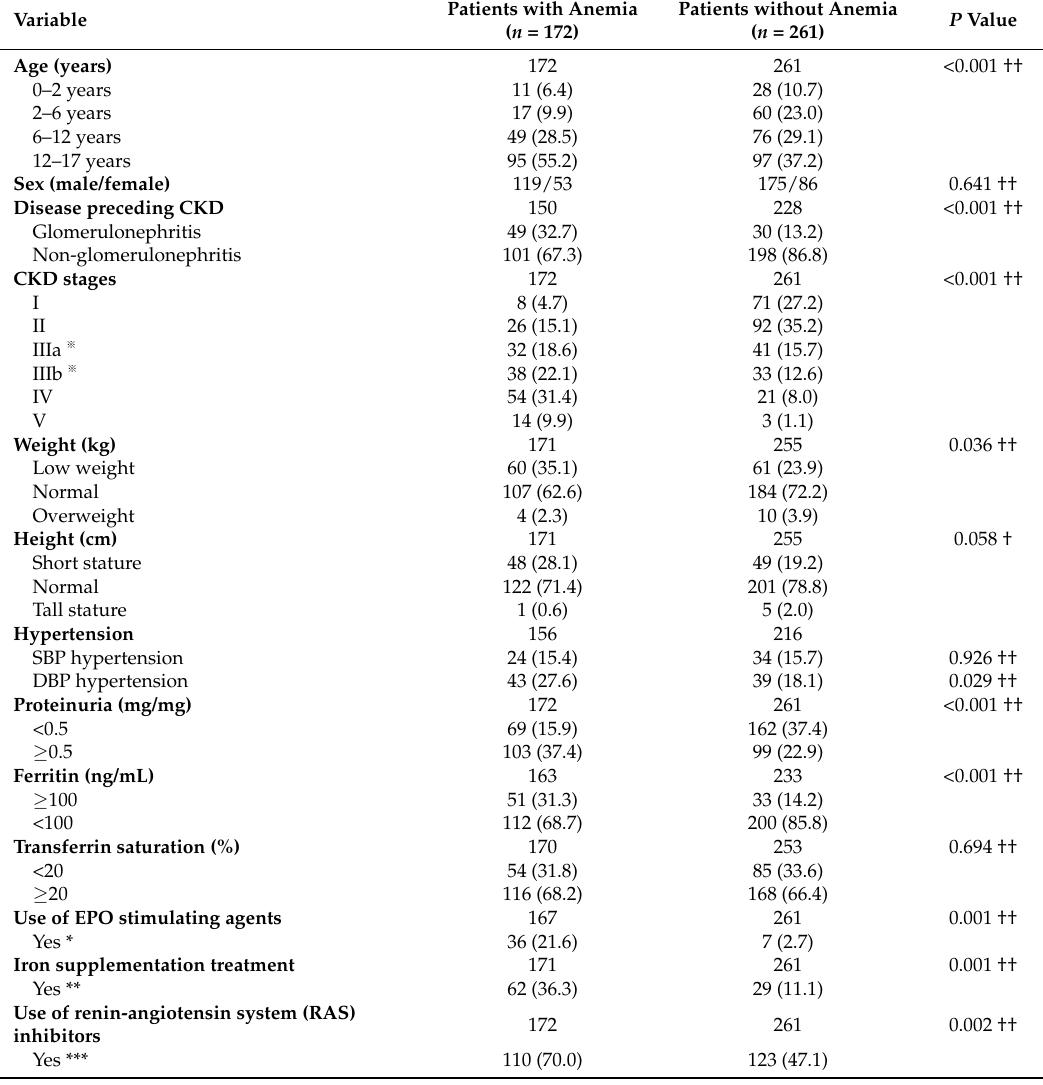
Table 2. Comparisons of characteristics of patients with anemia in the CKD cohort analysis.